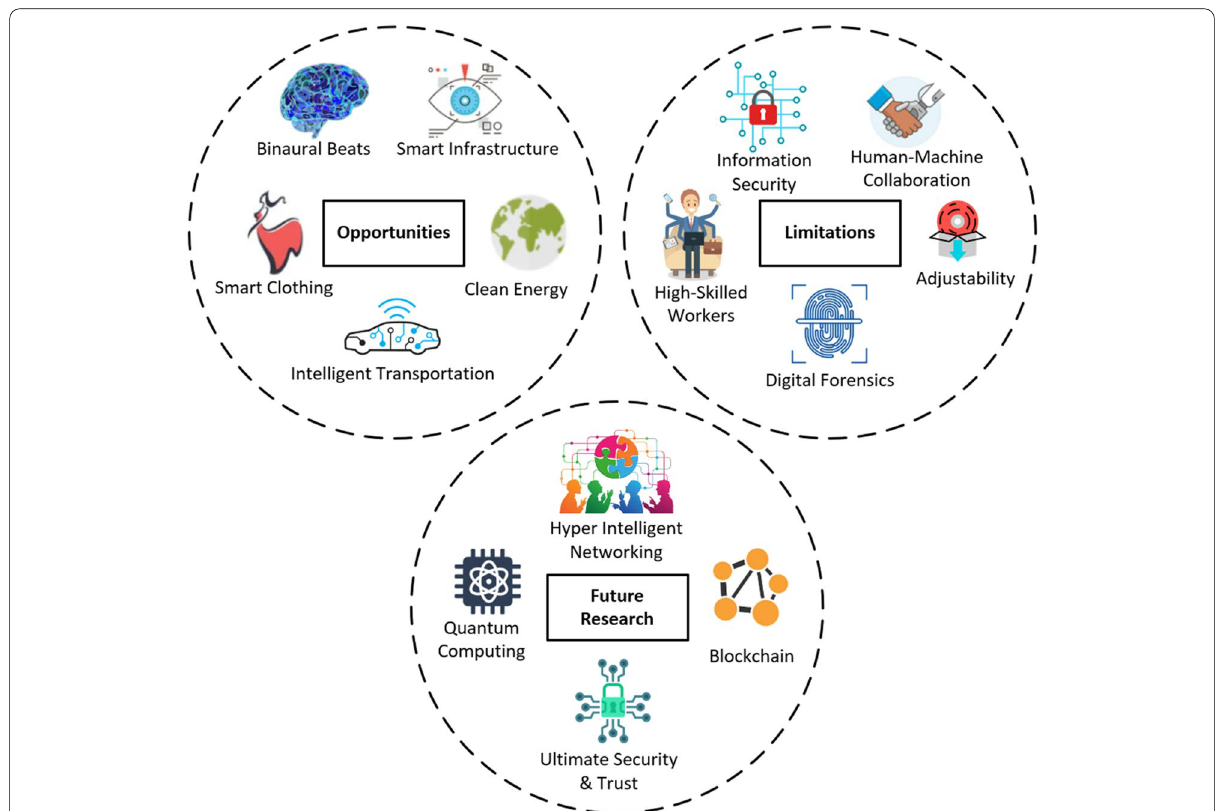
Fig. 4 Opportunities, Limitations, and Future Research of Industry